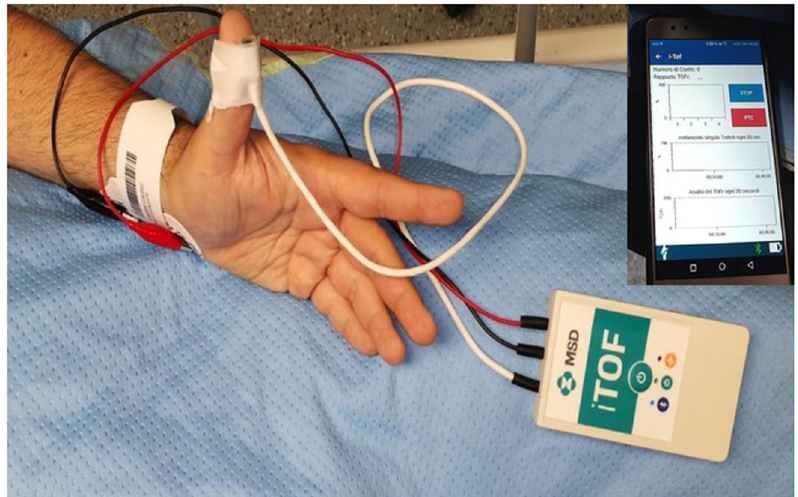
Fig. 1 The i-TOF Device. The i-TOF device consists of a triaxial accelerometer, two poles for nerve stimulation, and wireless connection on a smartphone by application. Table 1. Number of patients undergoing different surgical procedures. Surgical procedure No.